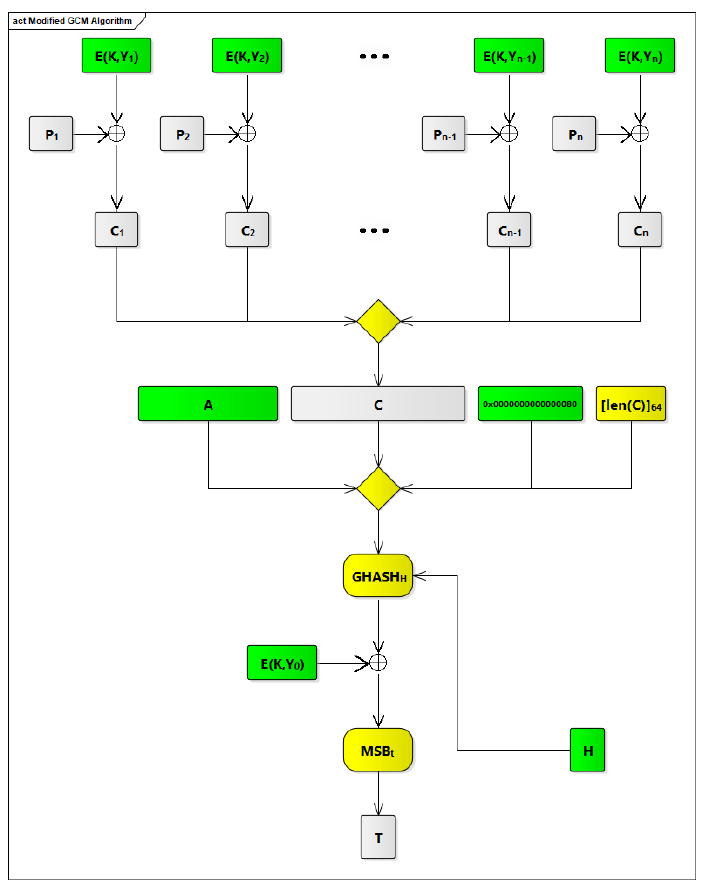
Figure 9. The modified GCM